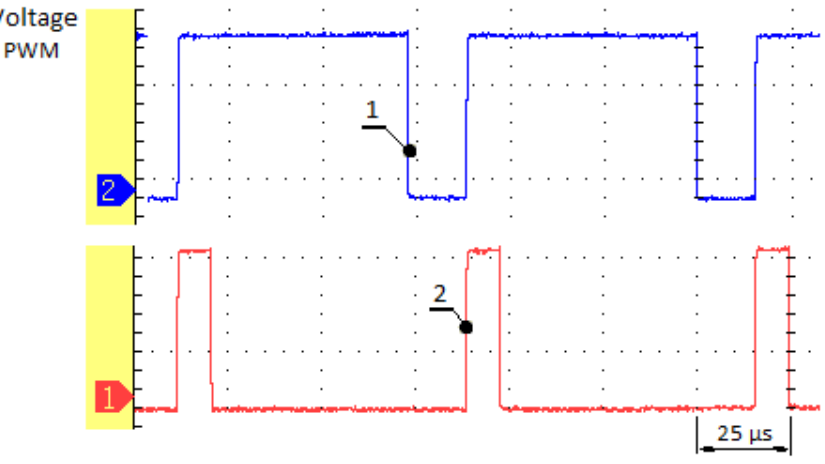
Figure 18. Buck-Boost mode of operation. 1–PWM on the Buck side, transistor Q1; 2–PWM on the Boost side, transistor Q2.